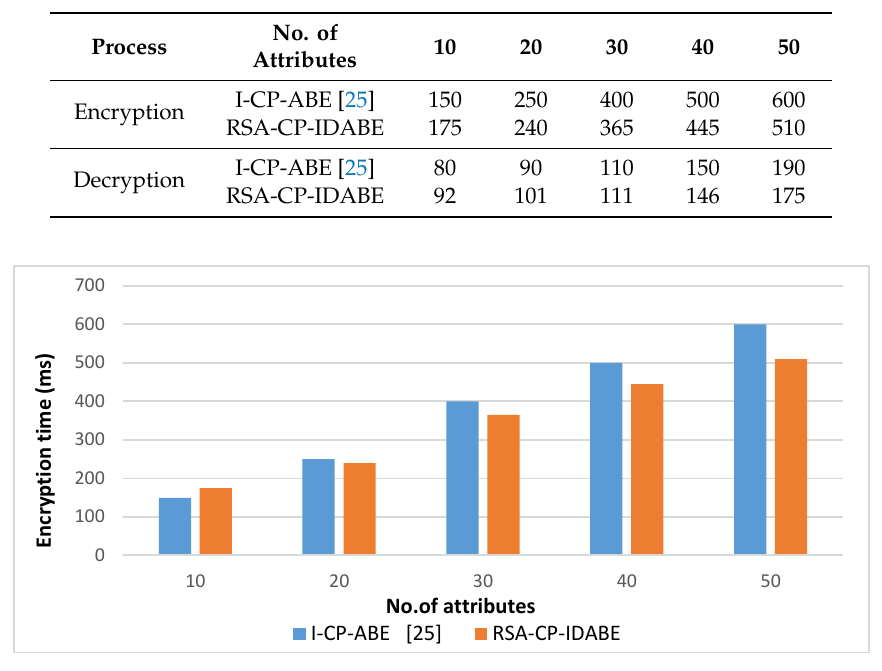
Figure 7. Comparison between the proposed RSA-CP-IDABE and I-CP-ABE for decryption time.